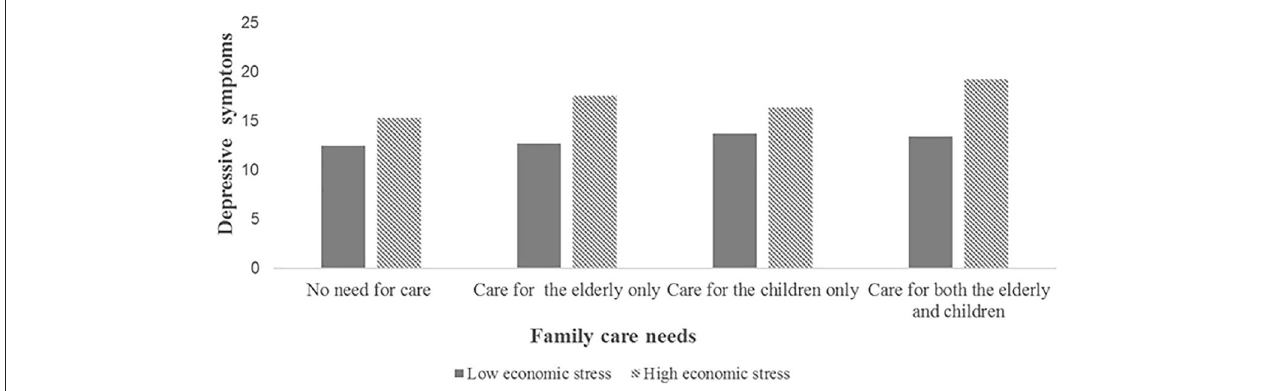
FIGURE 2 | The interaction effect of family care needs and economic stress on depressive symptoms in the overall sample.